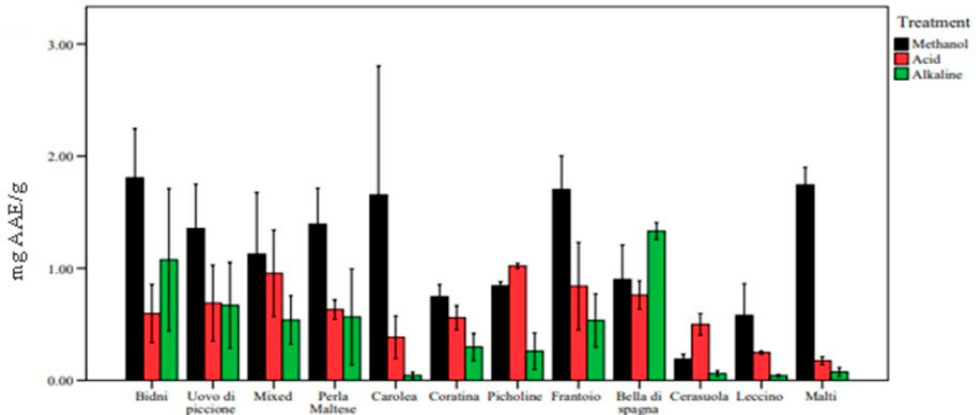
Figure 8. Mean values for hydrogen peroxide scavenging activity of olive mill waste extracts using three different solvent extraction methods—methanol, acid and alkaline (black, red and green bars, respectively) with error bars showing ± 1SD for three independent trails.